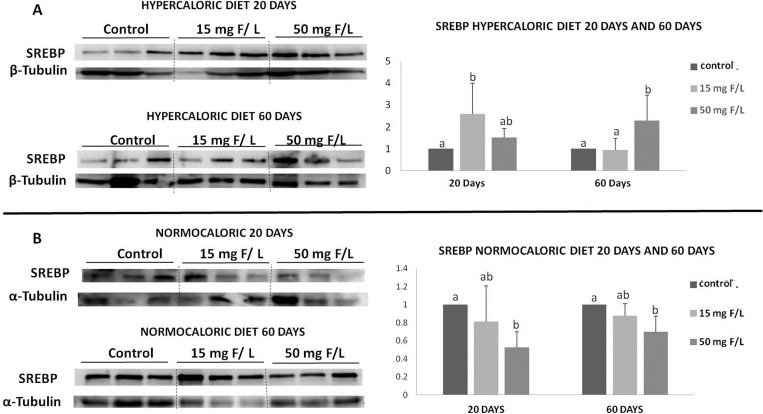
Representative expression of proteins SREBP, and of the constitutive protein β-tubulin ou α-tubulin in samples of individual animals (n = 3) from each group.Densitometric analysis was performed for 6 animals per group. A. Protein expression in the liver of rats in the group treated with the hypercaloric diet for 20 and 60 days; B. Protein expression in the liver of rats treated with the normocaloric diet for 20 and 60 days. Densitometry was analyzed using the software Image Studio Lite. Vertical bars represent standard deviations. Distinct superscript denote significant differences among the groups (ANOVA and Tukey’s test, p<0.05, n = 6).